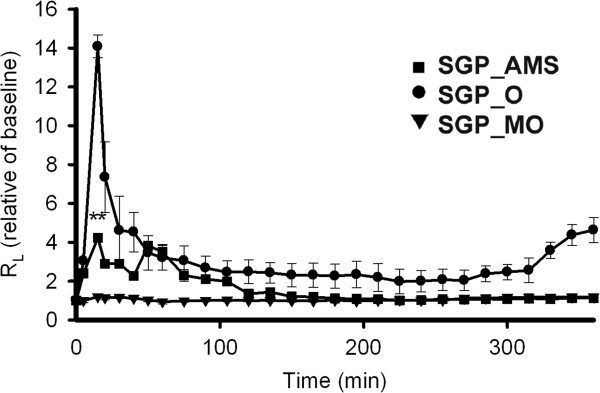
The inhibitory effect of the CTCM on OVA-induced RL increase is mediated by the β-adrenergic receptor. OVA-sensitized guinea pigs were pre-treated with the β-adrenoceptor antagonist propranolol, followed by CTCM inhalation or no CTCM inhalation before OVA challenge. Comparison between the SGP_O, SGP_MO and SGP_AMO groups of sensitized animals in a 7-hr period (repeated measures ANOVA with a Mauchly post-hoc test, SGP_AMO vs. SGP_MO; **P <0.01). Each point represents the mean of the data from 10-12 animals and the vertical bars represent the standard deviation. SGP_O: sensitized guinea pigs challenged with OVA by nebulization; SGP_MO: sensitized guinea pigs treated with 0.06 g/ml nebulized CTCM for 5 min, followed by OVA challenge by nebulization (at 5 min post-CTCM nebulization); SGP_AMO: sensitized guinea pigs pre-treated with β-adrenoceptor antagonist propranolol (1 mg/kg i.v.) for 3 min before treating with nebulized 0.06 g/ml CTCM for 5 min, and finally challenged by OVA by nebulization (at 5 min post-CTCM).